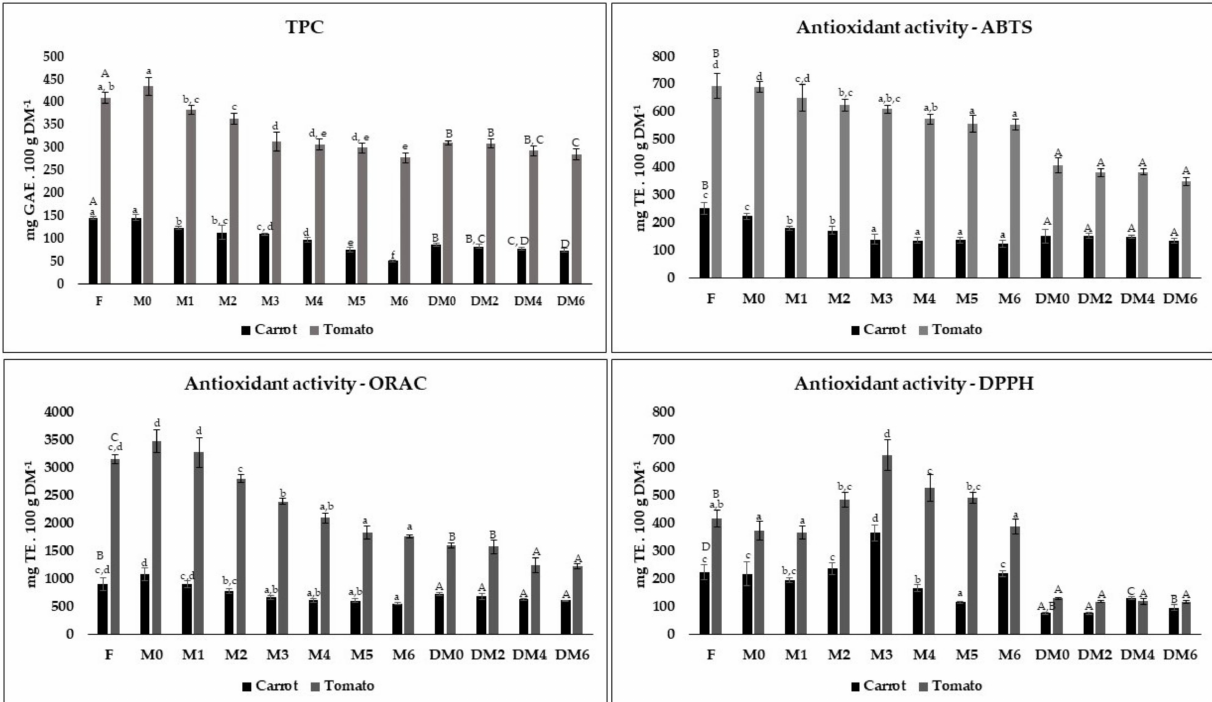
Figure 1. Total phenolic compounds (TPC; Folin–Ciocalteu method) and antioxidant capacity by ABTS, ORAC and DPPH assays ( n = 4) of fresh carrot and tomato by-products and during the pulps freezing and drying storage. All antioxidant results (mean ± standard deviation) were expressed in mg Trolox equivalent (TE) 100 g − 1 on a dry basis, while TPC results were represented in mg gallic acid equivalent (GAE) 100 g − 1 . Bars of the same color and corresponding to the same storage method with different superscript letters are significantly different ( p < 0.05). Lowercase letters were used for fresh and frozen pulps forms while uppercase letters were used for fresh and dry powders forms. M0 = 24 h after the freezing storage of pulps. M1, M2, M3, M4, M5, M6 = month one, two, three, four, five and six of the freezing storage of pulps, respectively. DM0 = day 0 of the powders storage. DM2, DM4, DM6 = month two, four and six of the storage period of